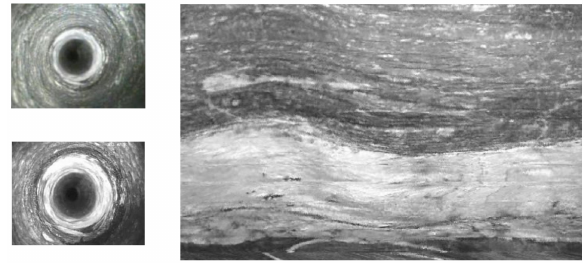
Figure 23. Borehole-wall cylindrical panorama generated from the first video.